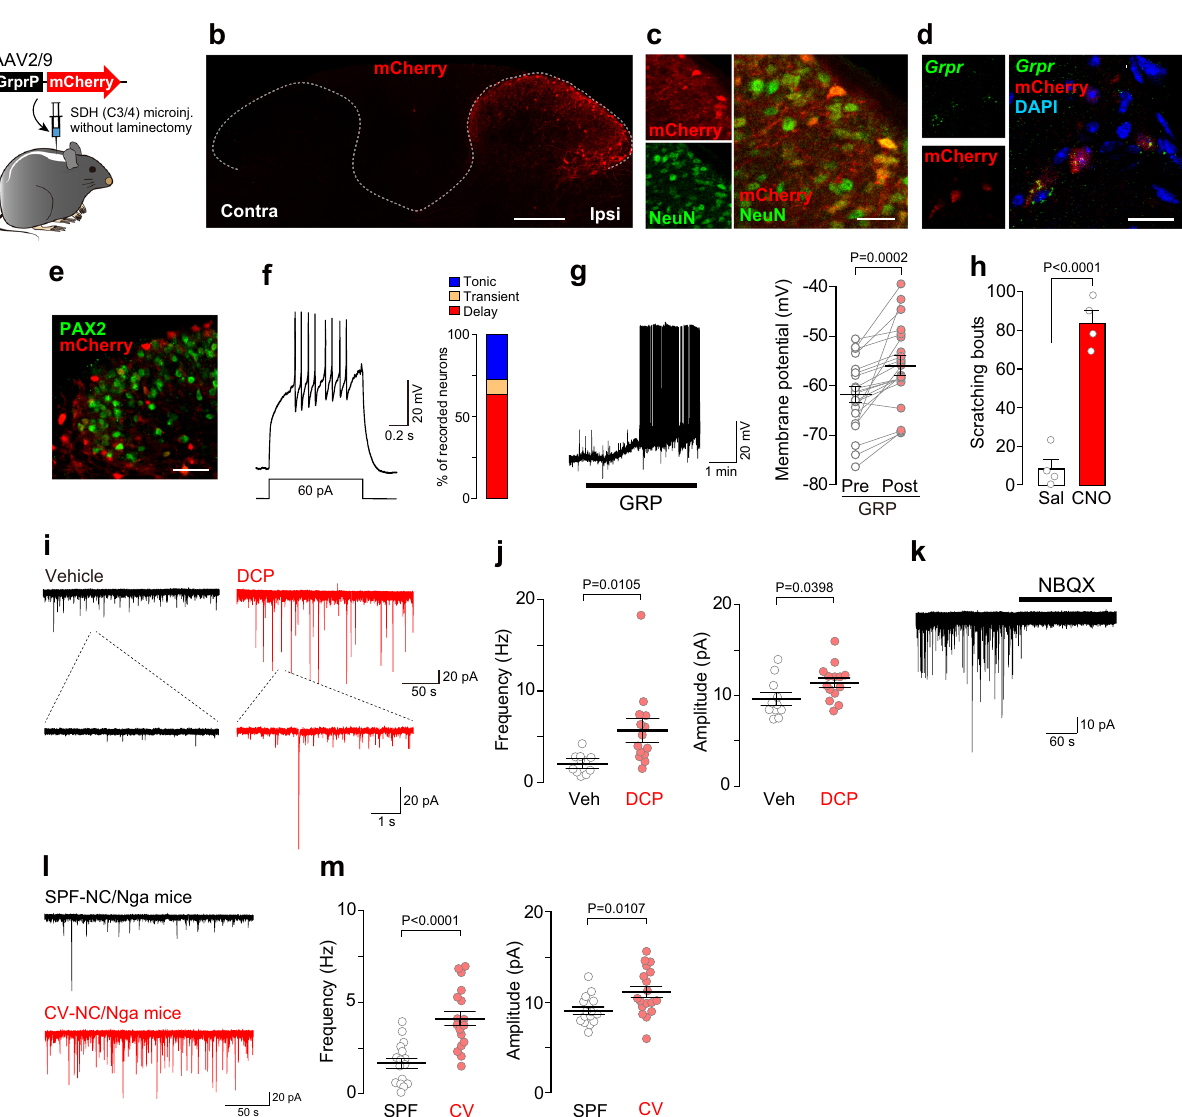
Fig. 1 Facilitation of glutamatergic synaptic inputs onto GRPR + SDH neurons in mouse models of chronic itch. a Schematic illustration of microinjection of AAV-GrprP-mCherry into the cervical SDH. b , c Visualization of mCherry + cells (red) in the SDH ( b ), and immunolabeling of mCherry + cells (red) by a pan-neuronal marker, NeuN (green) ( c ). d RNAscope in situ hybridization for Grpr mRNA (green) in mCherry + cells (red) in the SDH. e Immunolabeling of mCherry + cells (red) by an inhibitory neuronal marker, PAX2 (green). Scale bars, 200 μ m ( b ), 50 μ m ( e ), 20 μ m ( c , d ). f Firing patterns of mCherry + neurons in cervical spinal cord slices. Representative traces of delayed fi ring pattern evoked by injecting a depolarizing current, and the percentage of mCherry + neurons displaying each pattern ( n = 22 cells). g Representative response of GRP (200 nM) in mCherry + neurons (displaying the delayed fi ring pattern), and the summary of the membrane potential of pre- and post-GRP application ( n = 21 cells, paired t test). h Number of scratching behavior for 30 min after injection of clozapine-N-oxide (CNO, 10 mg/kg, i.p.) or saline in AAV-GrprP-hM3Dq mice ( n = 4/group, unpaired t test). i , j Representative traces ( i ) and the average of frequency and amplitude ( j ) of sEPSCs in GRPR + (mCherry + ) SDH neurons of vehicle- and DCP-treated mice (vehicle, n = 11 cells; DCP, n = 14 cells; unpaired t test). k Representative traces of sEPSCs in GRPR + (mCherry + ) neurons of DCP-treated mice after application of NBQX, an antagonist for AMPARs. l , m Representative traces ( l ) and the frequency and amplitude ( m ) of sEPSC in SDH GRPR + (mCherry + ) neurons in SPF- and CV-NC/Nga mice (SPF, n = 16 cells; CV, n = 18 cells; unpaired t test). Values represent mean ± S.E.M. Source data are provided as a Source Data fi Toenail trimming prevents synaptic facilitation in GRPR + spontaneous scratching is observed when maintained under SDH neurons . Because the itch-scratch cycle is a critical com- conventional (CV-NC/Nga), but not under speci fi c-pathogen- free (SPF-NC/Nga) conditions 19 . Compared with SPF-NC/Nga ponent of chronic itch, we examined its involvement in the mice, the frequency and amplitude of sEPSCs in GRPR + SDH facilitation of synaptic responses in GRPR + neurons by trimming neurons were increased in CV-NC/Nga mice (Fig. 1l – m). These the toenails of mice to prevent scratch-induced skin damage 7 . In DCP-treated mice we observed that trimming the toenail reduced results provide evidence that AMPAR-mediated glutamatergic the scratching behavior and skin lesion (Supplementary Fig. 2a, synaptic inputs onto GRPR + neurons in the SDH are facilitated b), thereby suppressing the facilitation of synaptic responses in under chronic itch-like conditions.